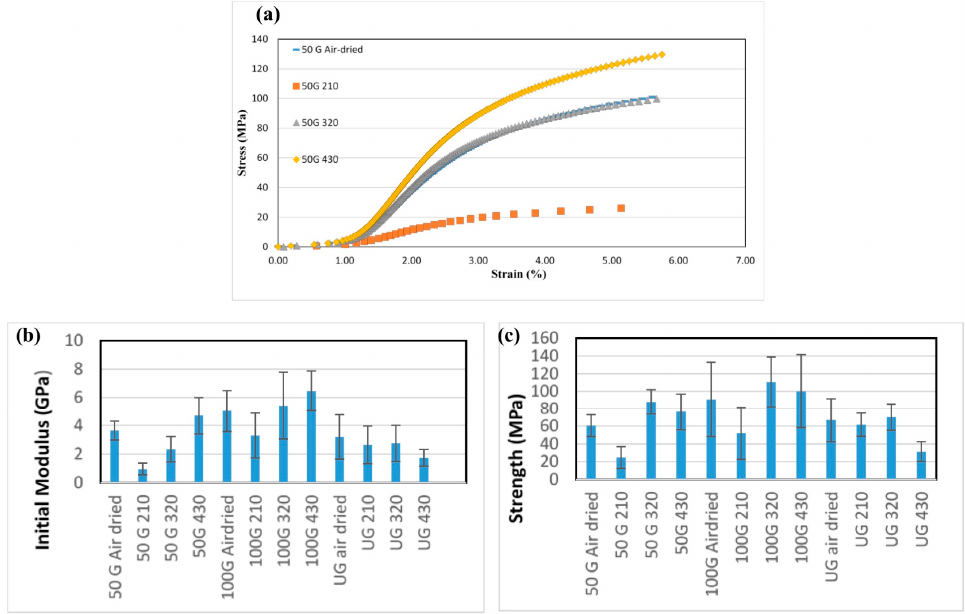
Figure 6. ( a )Typical stress/strain curves of filaments made from the 50G sample dried at different temperatures. Results of a tensile tests of the filaments: ( b ) Young’s modulus or initial modulus of the filaments; ( c ) strength of the filaments.